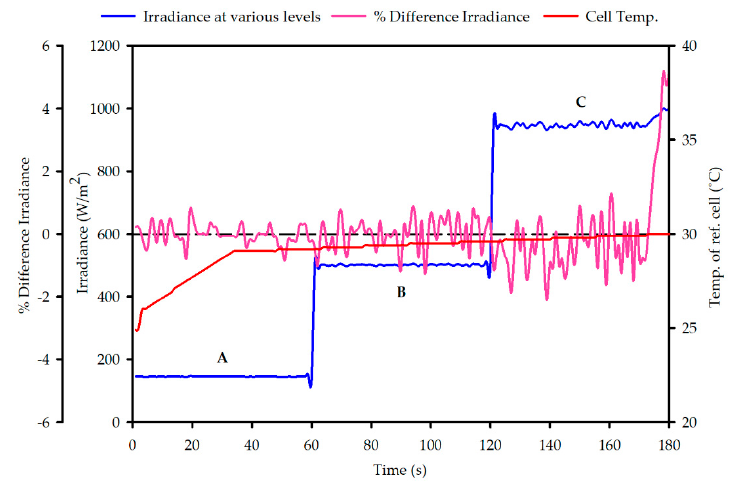
Figure 9. Solar simulator operated at varying set points of its rated current.